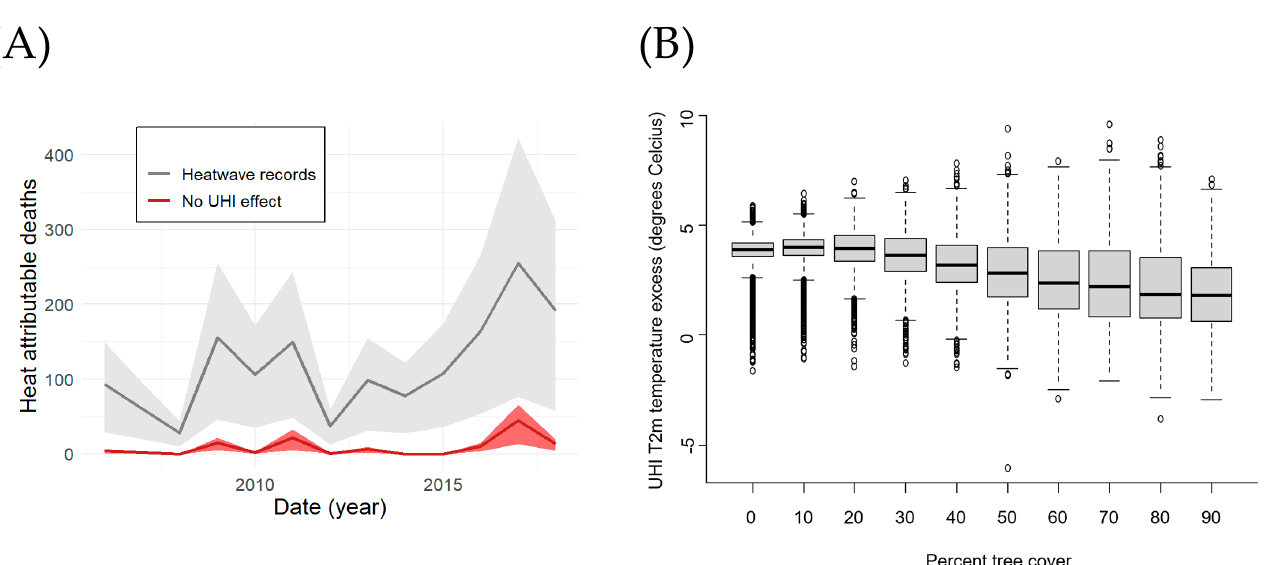
Figure 3. ( A ) Time-series of heat-attributable numbers (AN) of deaths in Sydney GMR with (grey) and without (red) the urban heat island (UHI) effect. Heat ANs in the absence of the UHI effect were calculated for all years using the UHI anomalies from the summer of 2015/2016. The total population of the Sydney GMR was 5.6 million in 2018. ( B ) Urban heat island (UHI) air temperature (T2m) anomaly by percentage tree cover; each data point represents a mesh block.